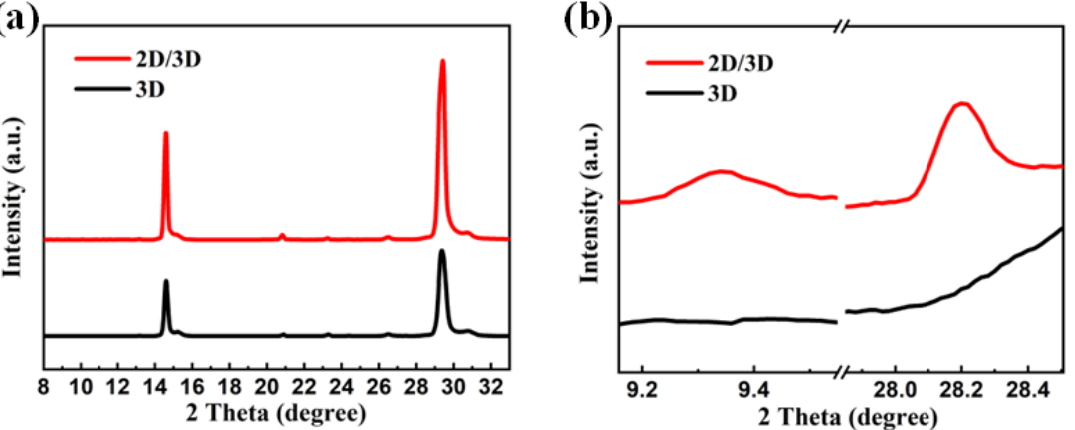
Figure 1. ( a ) Global XRD spectra and ( b ) local magnified XRD spectra of 3D and 2D/3D perovskite films.